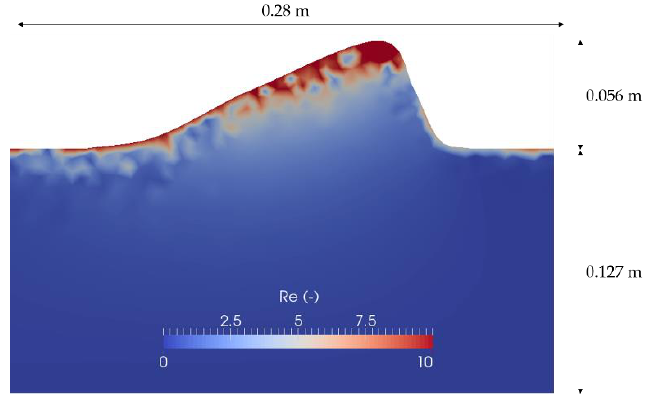
Figure 12. Reynolds numbers at a sandy ripple for case 5